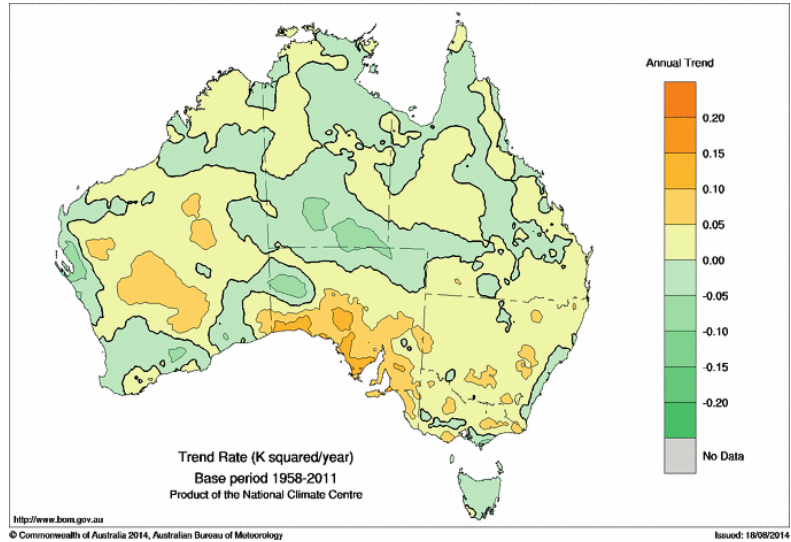
Figure 11. Trend in the intensity of EHF-positive events across 1958–2011. Values are expressed in units of K 2 per